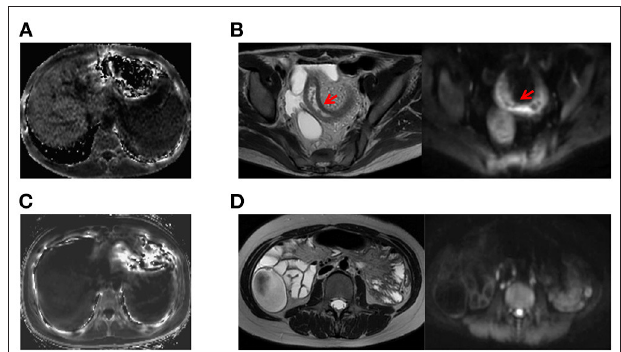
FIGURE 2 | Examples of comparative MRE images obtained from patients with active CD and inactive CD. (A) A patient with active CD who showed higher liver signal intensity on the R2* map (R2* = 93.074; CDAI value, 233). (B) Corresponding T2-weighted and diffusion-weighted images of a patient with active CD showing inflammation of the bowel wall, including thickening of the wall of the ileum with an increased signal, rough mucosal surface, and a small amount of pelvic cavity effusion. (C) MRE image of a patient with inactive CD on the R2* map (R2* = 14.12, CDAI value, 73). (D) Corresponding T2-weighted and diffusion-weighted images for a patient with inactive CD. CD, Crohn’s disease; CDAI, Crohn’s Disease Activity Index; MRE, magnetic resonance